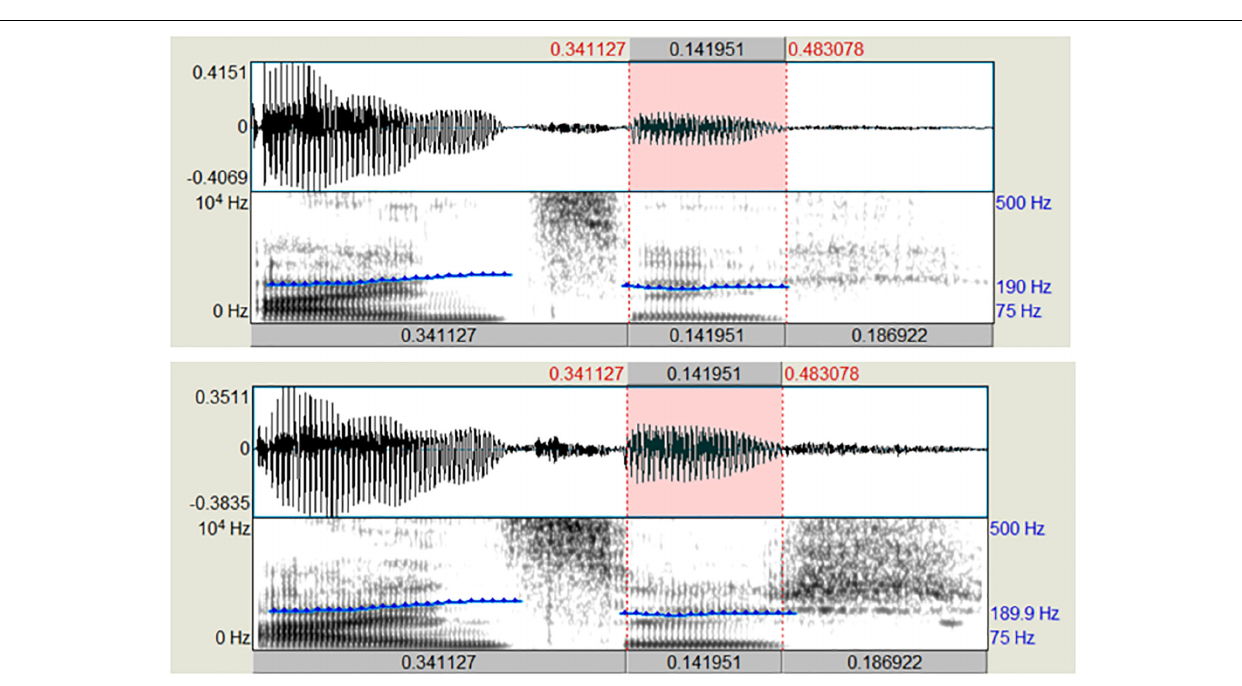
FIGURE 4 | Spectrogram and oscillogram of the einzig -pair with temporally adjusted segments and normalized pitch contour (above: canonical realization , below: non-canonical realization